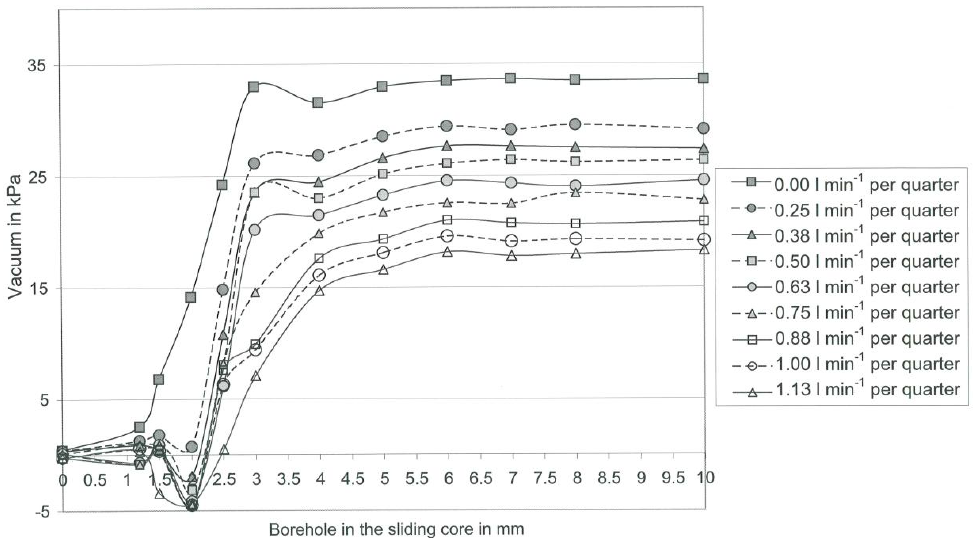
Figure 5. Characteristic curve of mean teat-end vacuum in d-phase, depending on the diameter of the boreholes in the sliding cores and depending on the liquid flow rate per udder quarter